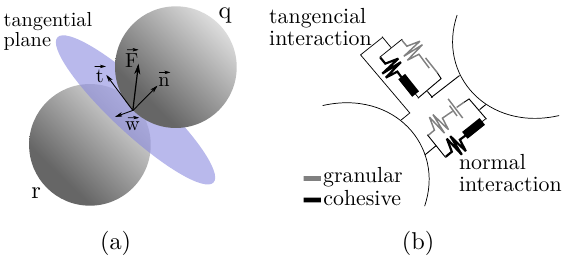
Figure 1. Schematic representation of a paired interaction in 3D (a), with parallel implementation of the contact model (b).